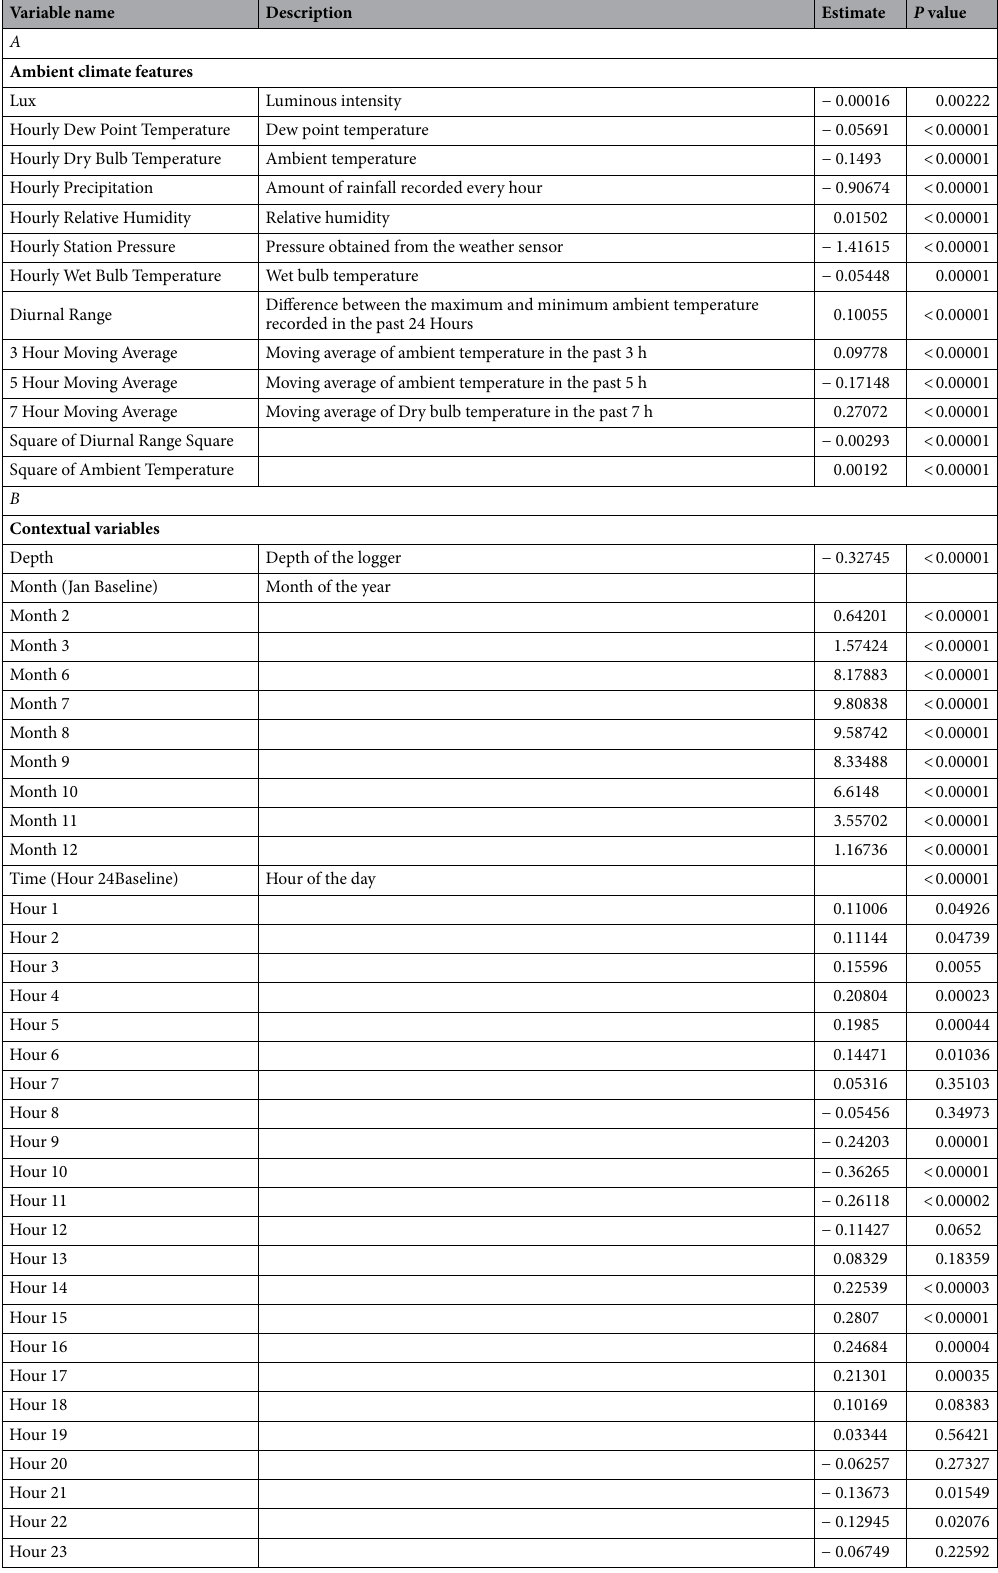
Table 1. Variables used for